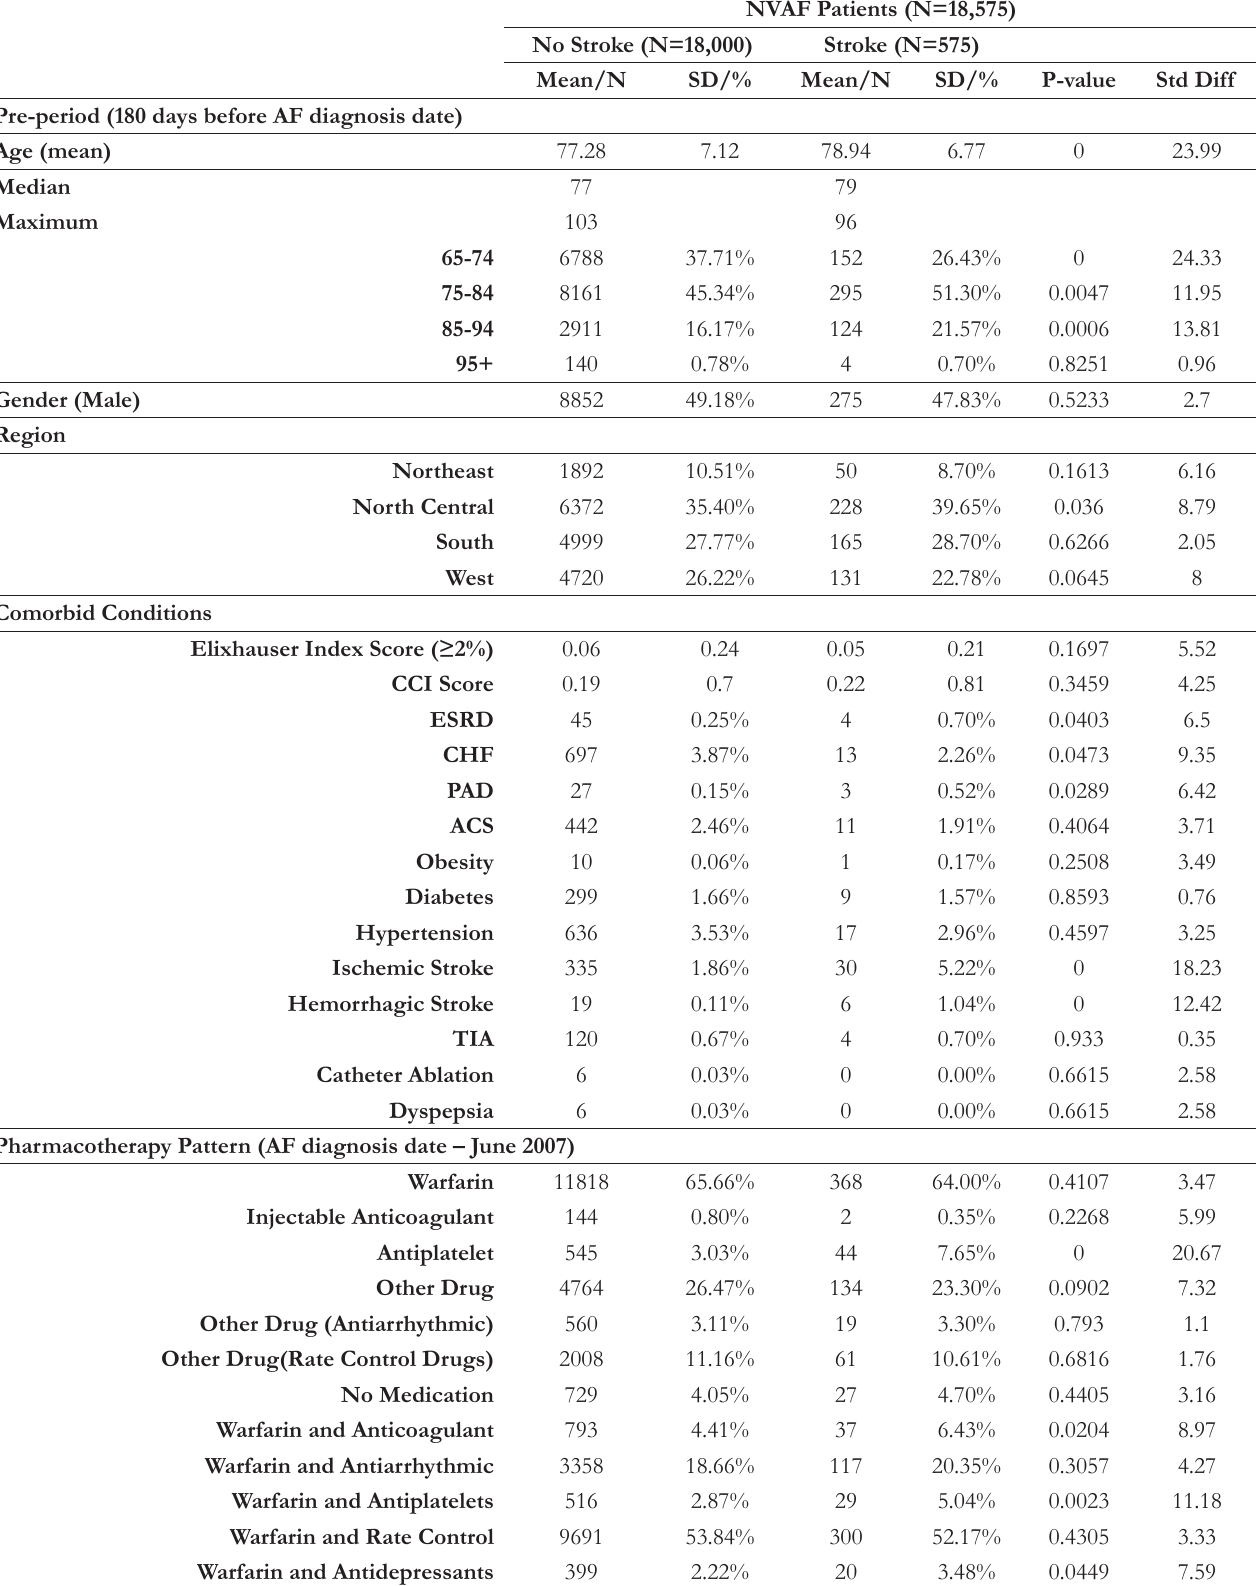
Table 2. Descriptive Statistics for NVAF Patients who did or did not Experience a